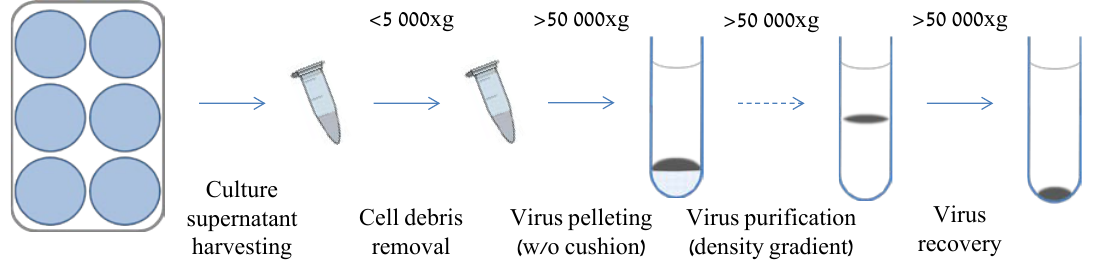
Figure 2. General workflow for the purification of a herpesvirus. Extracellular virions are purified using centrifugation on density gradient, sometimes preceded by concentration on a sucrose cushion.